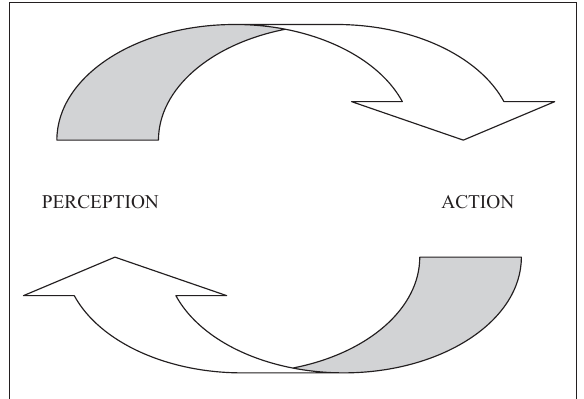
Figure 2. Circular causality of ecological psychology: Perception creates action and action creates a new